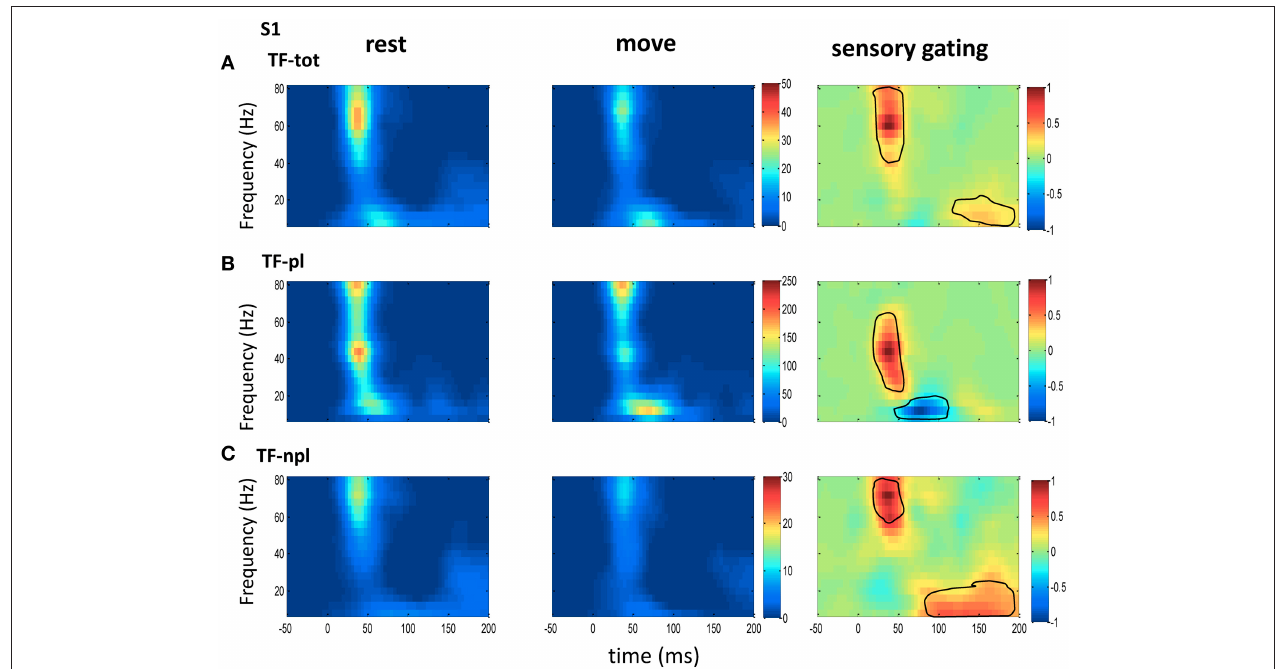
FIGURE 3 | The grand average powers in S1. (A) Total powers during rest (left) and move (right) show early high gamma oscillations followed by weak low frequency oscillations, which starts earlier than that in VPL ( Figure 2 ). Movement induced sensory gating (right) is stronger at high gamma band than later low frequency band. (B) Compared to that of total power, the phase-locked power shows low frequency shifted pattern, and the sensory gating only at low gamma band while an elevation at low frequency band. (C) Non-phase-locked power shows dominant high frequency oscillation, and sensory gating presents strong early high gamma band and weak late low frequency band. The same convention of the colorbar and normalization is used in each map as in Figure 2 ( p < 0.05 for signrank test, n = 26 ).